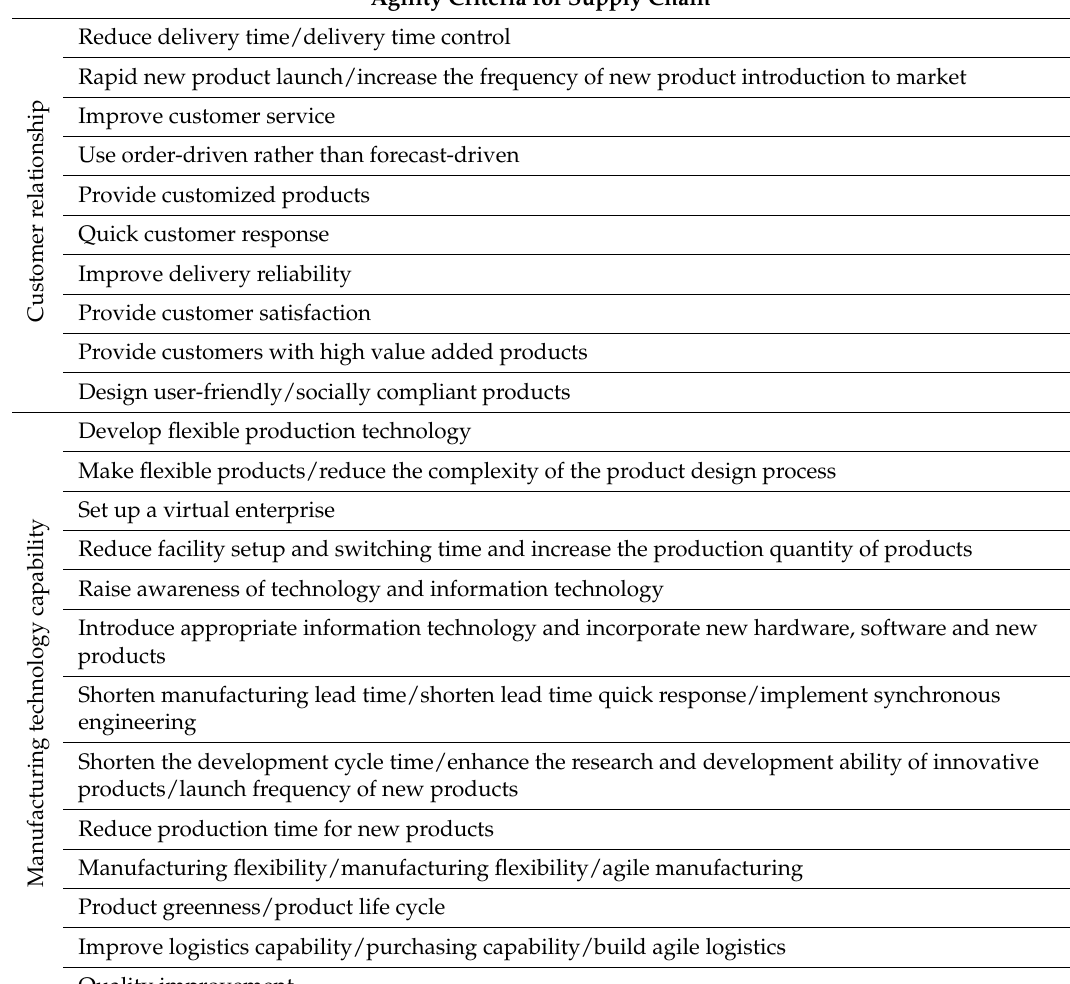
Table A2. Cont. Agility Criteria for Supply